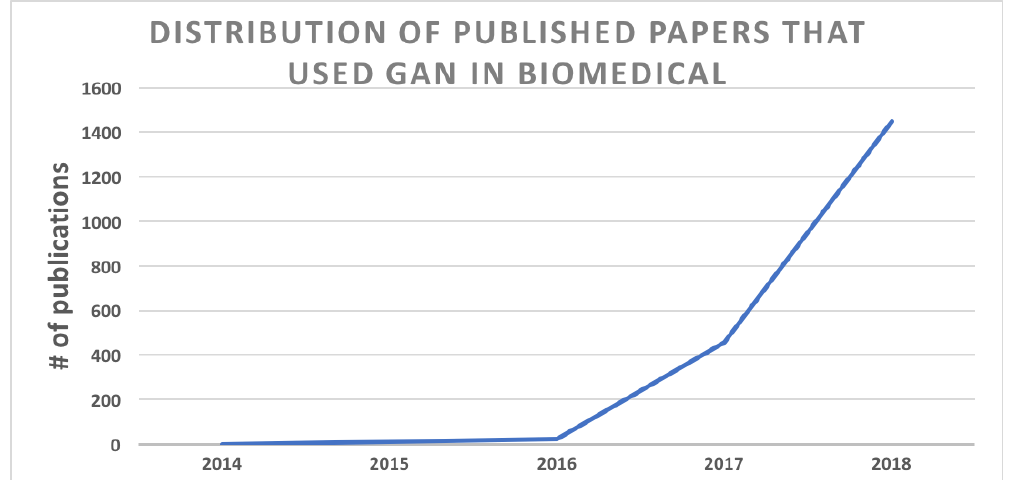
Figure 15. Distribution of published papers that use Generative Adversarial Networks (GANs) in biomedical applications. The statistics are obtained from Google